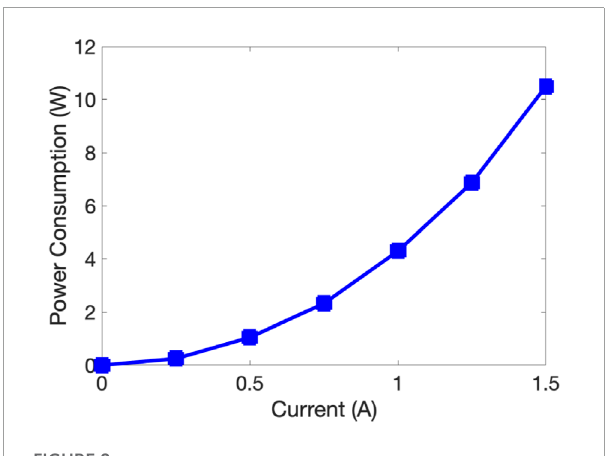
FIGURE 8 Power consumption of the 3D-printed